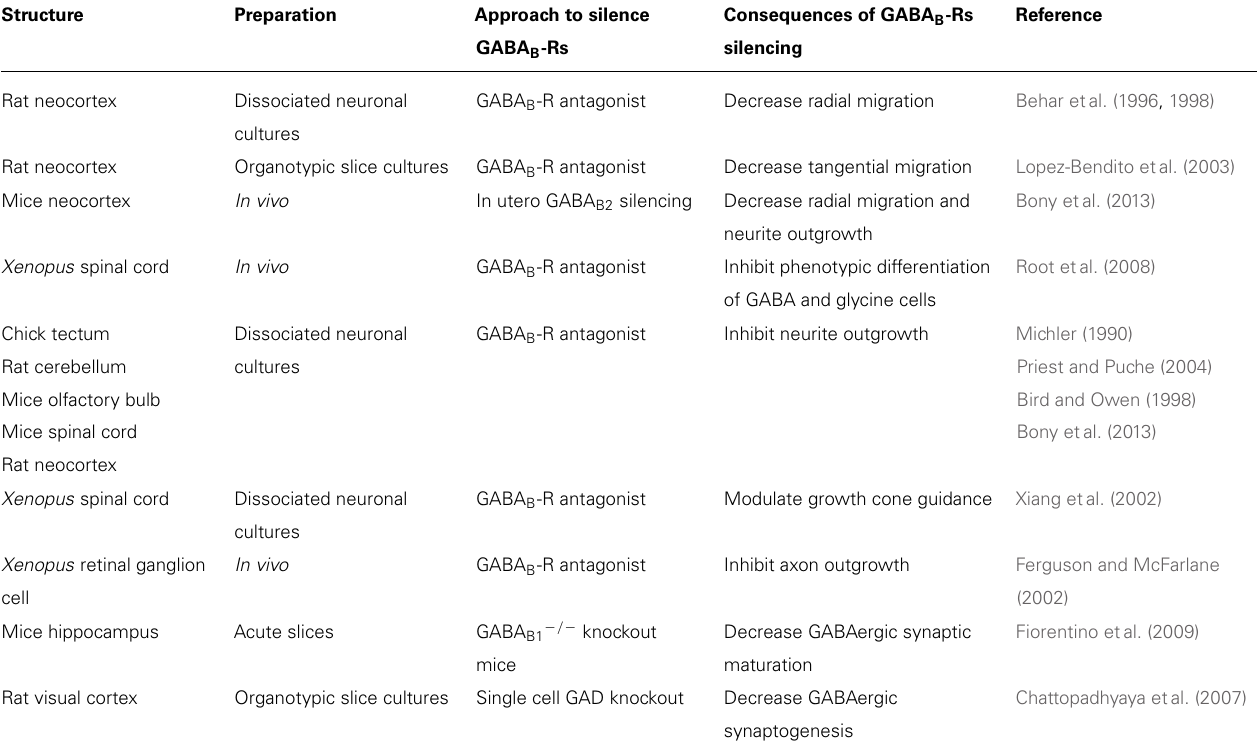
Table 1 | Neurotrophic action of GABA B